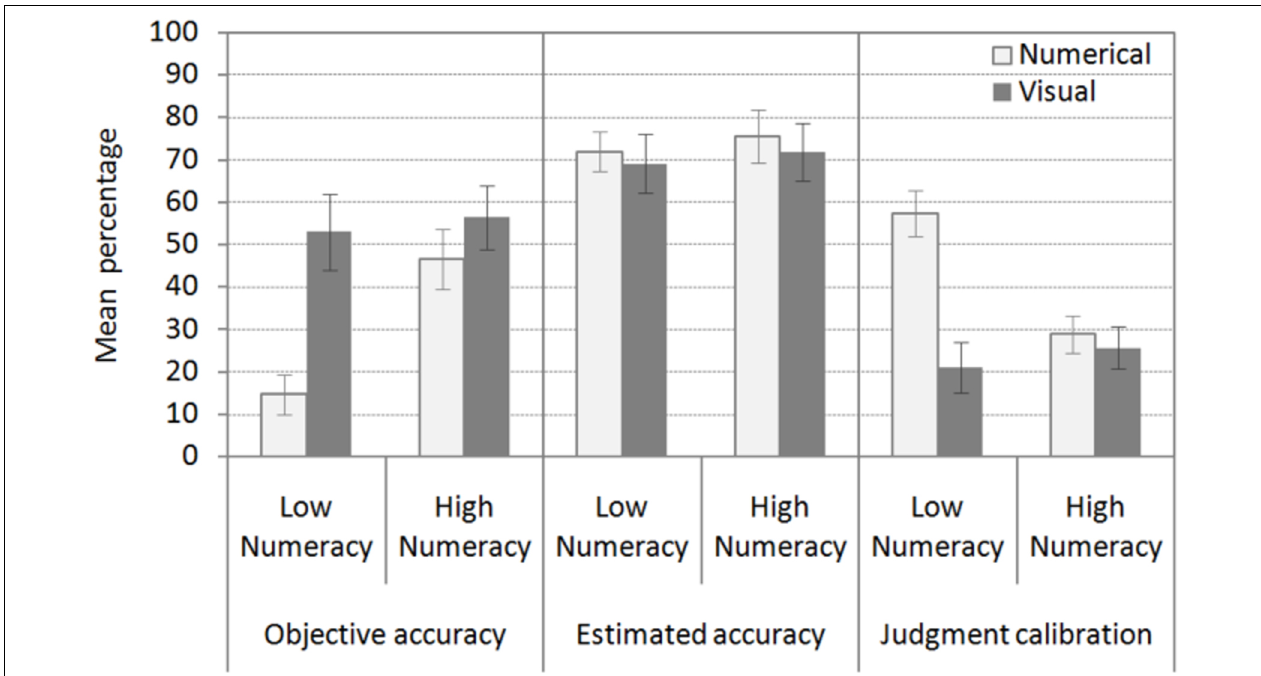
FIGURE 3 | Objective accuracy, estimated accuracy, and metacognitive judgment calibration across the three diagnostic tasks by information format and numeracy. Error bars indicate one standard error of the mean.